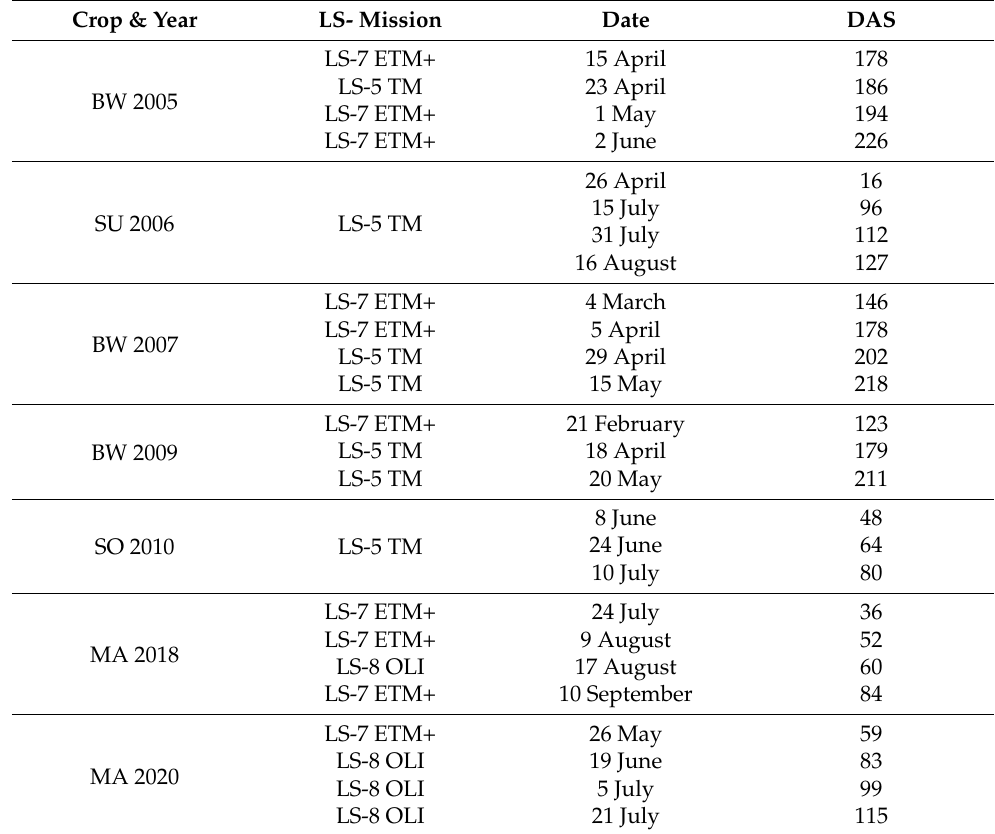
Table 2. Prospection of remotely sensed NDVI imagery and corresponding dates after sowing (DAS). Crop &